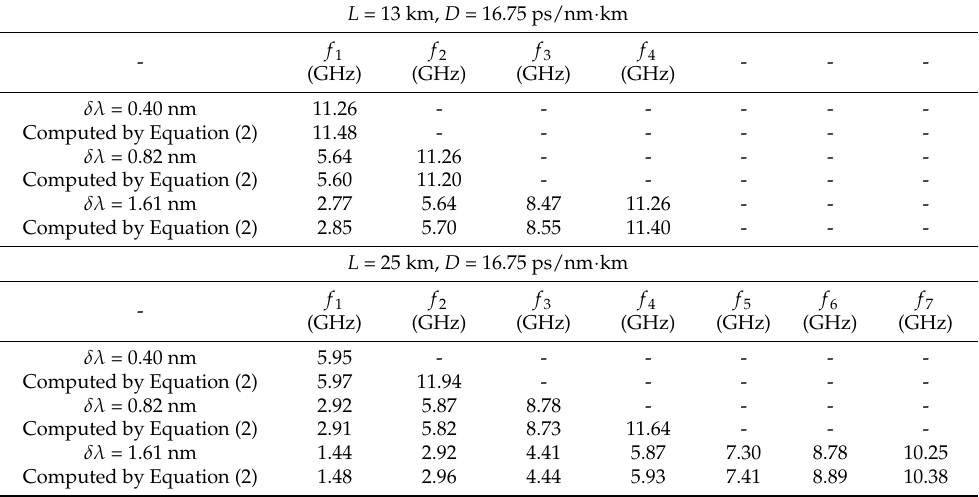
Table 1. Summary of